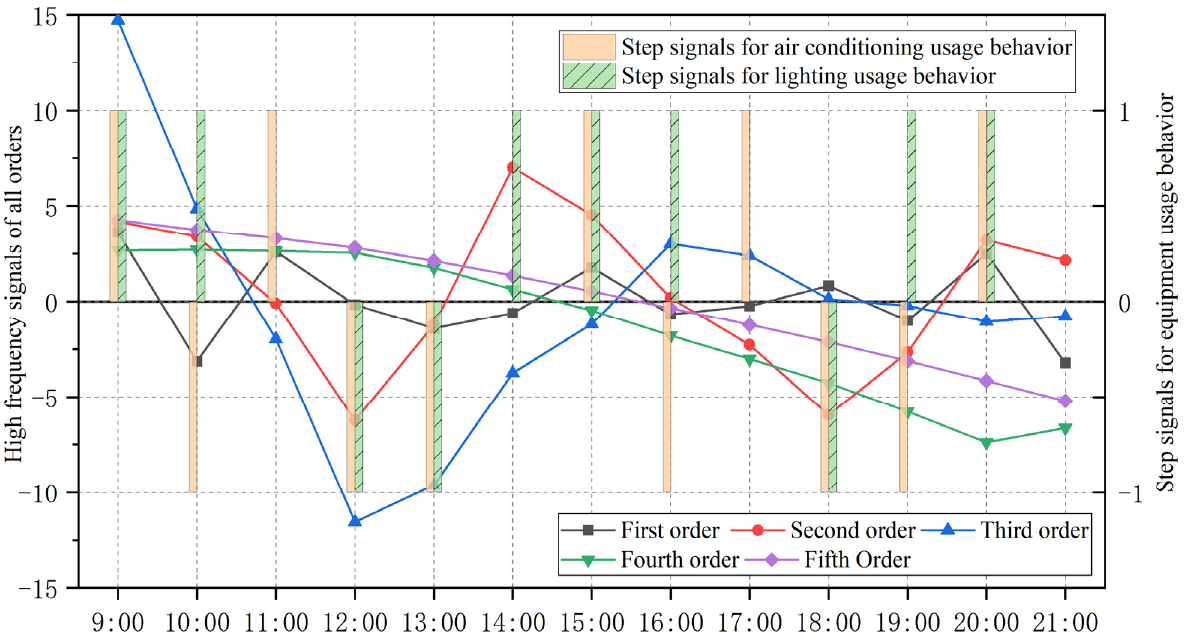
Figure 9. Decomposed and reconstructed high-frequency signals and numerical step signals. Table 5. Correlation between each order of high-frequency signals and the numerical step signals. Order